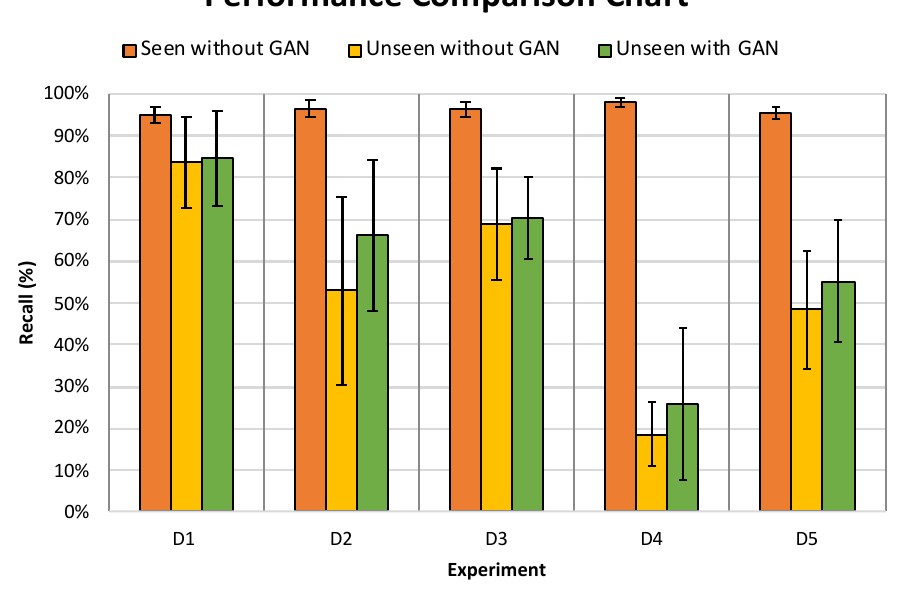
Figure 11. The performance of the average CNN models trained on the R4 vs. RG drone dataset and tested on unseen drones of in terms of recall